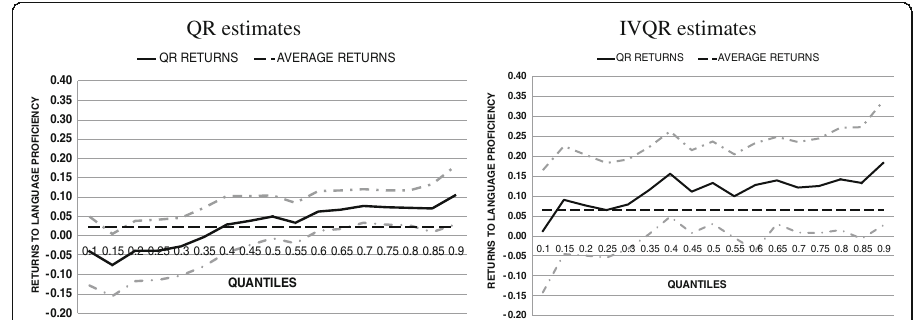
Fig. 3 QR and IVQR estimates — workers with less than upper secondary education. Note: (i) dotted line in QR returns denotes non-significant at those quintiles, (ii) upper and lower curves comprise the 95% confidence interval, and (iii) models with occupation